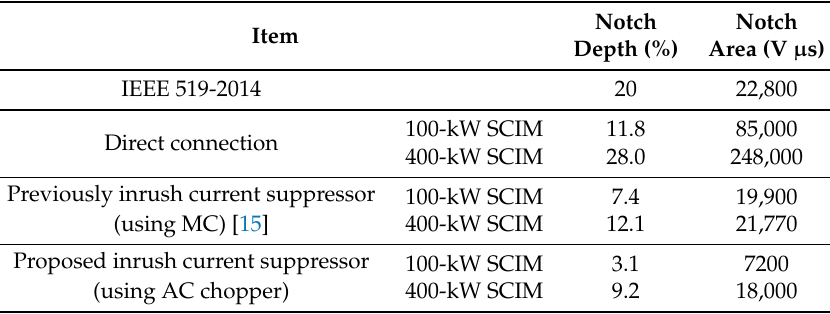
Table 4. Comparison of notch depth and area in IEEE Std